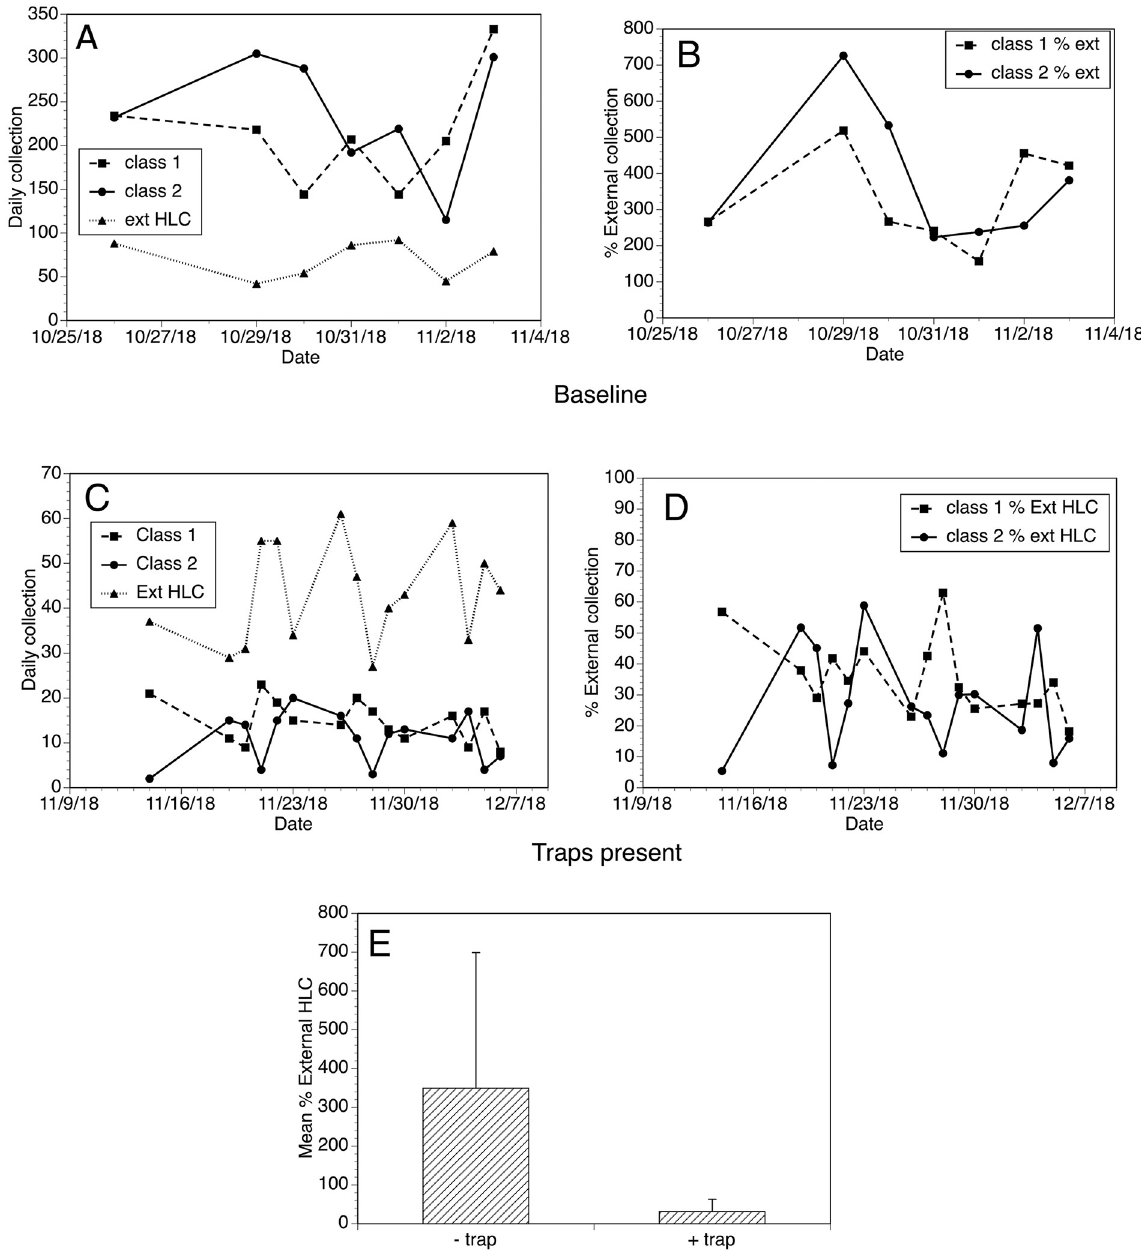
Fig 6. Evaluation of the ability of the optimized EWT to reduce biting in a school setting. The data were collected from two classrooms at Gonycogo Primary School and normalized for daily variations in the questing fly population using an external collector as described in Materials and Methods. Panel A: Daily collections obtained by the HLCs situated in the two classrooms and those obtained from the external collector in the absence of the traps. Panel B: Collections from the classrooms expressed as a percentage of the collection obtained by the external collector in the absence of the traps. Panel C: Daily collections obtained by the HLCs situated in the two classrooms and those obtained from the external collector in the presence of the traps. Panel D: Collections from the classrooms expressed as a percentage of the collection obtained by the external collector in the presence of the traps. Panel E: Mean collections obtained by the collectors in the classrooms normalized to those obtained by the external collector in the presence and absence of the traps. Bars represent the mean percentage of the collections obtained by the collectors relative to those obtained by the external collector in the presence and absence of the traps, and error bars the standard deviations of the normalized counts. Raw collection data for this study may be found in the S5 Table.